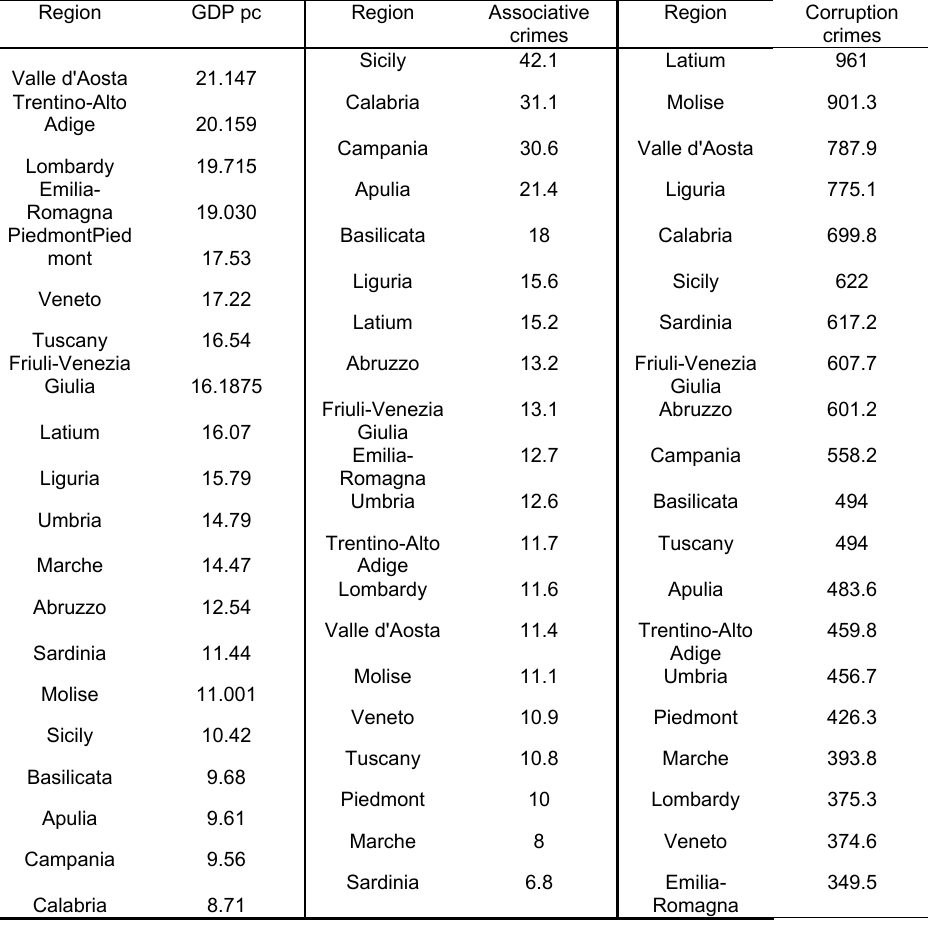
Table 1. GDP and prosecutions per capita (1980-2004, average annual data) Region GDP pc Region Associative Region Corruption crimes crimes Sicily 21.147